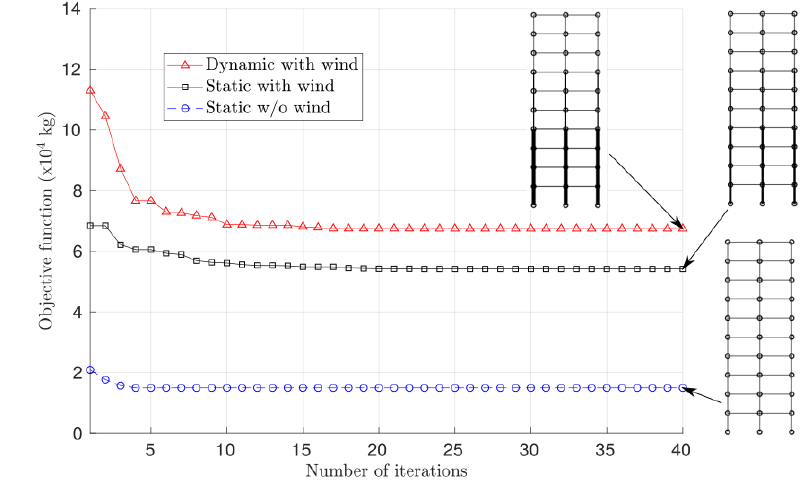
Figure 4. Convergence process for the three cases